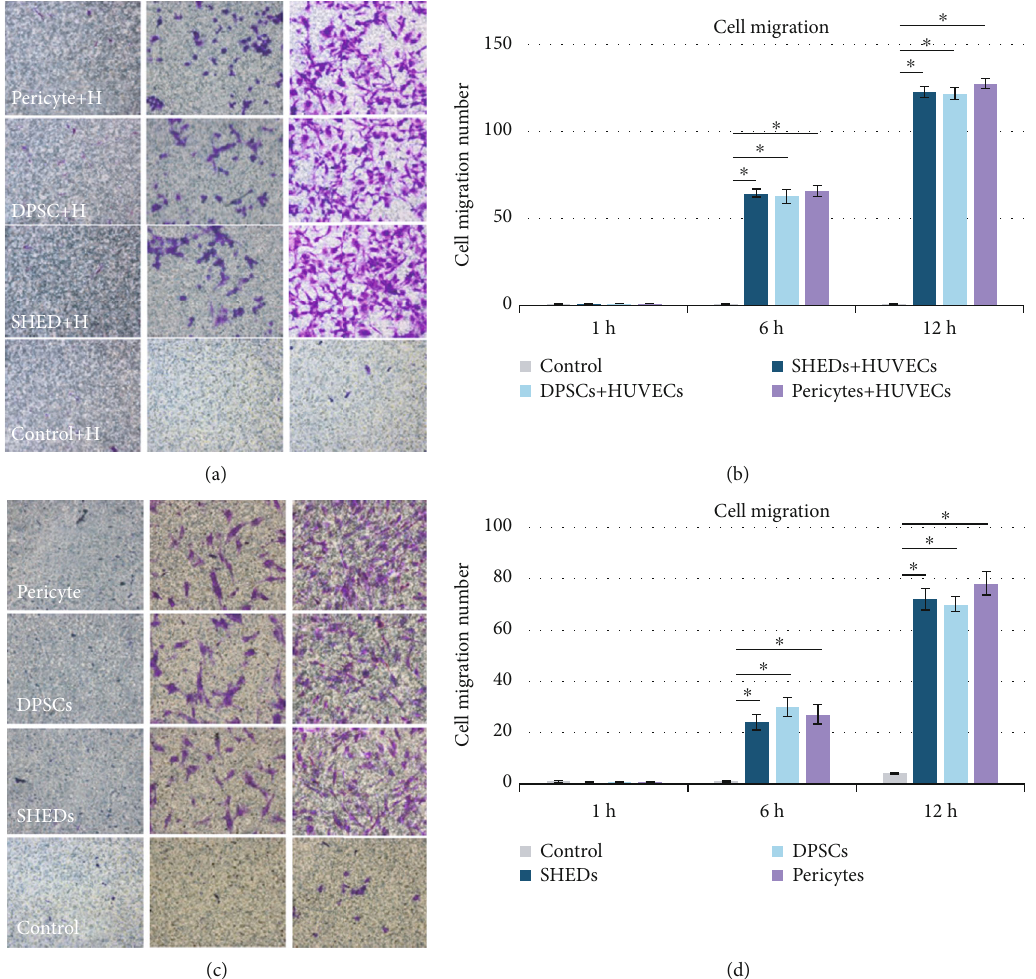
Figure 5: (a, b) The chemotactic e ff ects of stem cells from human exfoliated deciduous teeth (SHEDs), postnatal human dental pulp stem cells (DPSCs), and pericytes on human umbilical vein endothelial cells (HUVECs). (c, d) The migration capacities of SHEDs, DPSCs, and